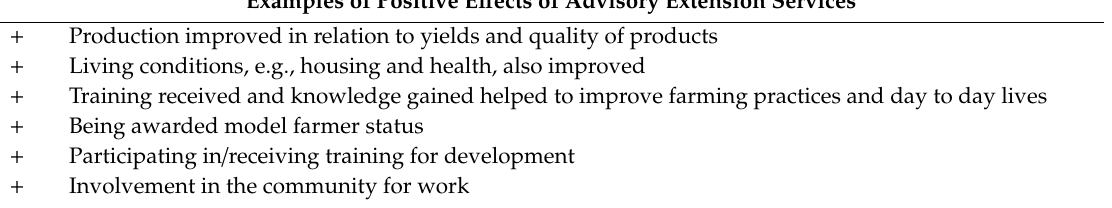
Table 5. Common Responses 1 from Questionnaire Survey / Focus Group Discussion and Activity Participants.